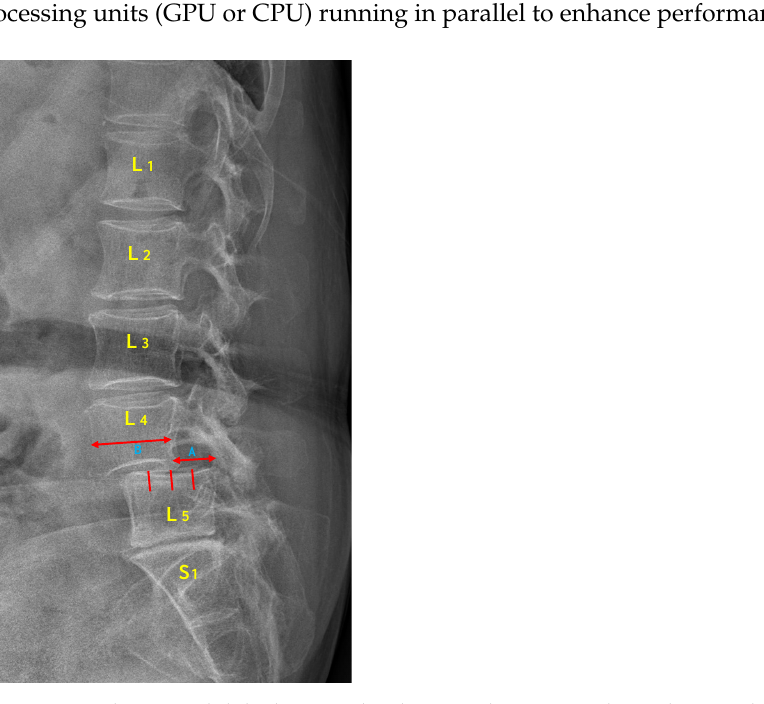
Figure 1. Lumbar spondylolisthesis. L: lumbar vertebra, S: sacral vertebra, A: slip distance between two vertebrae, B: width of the superior